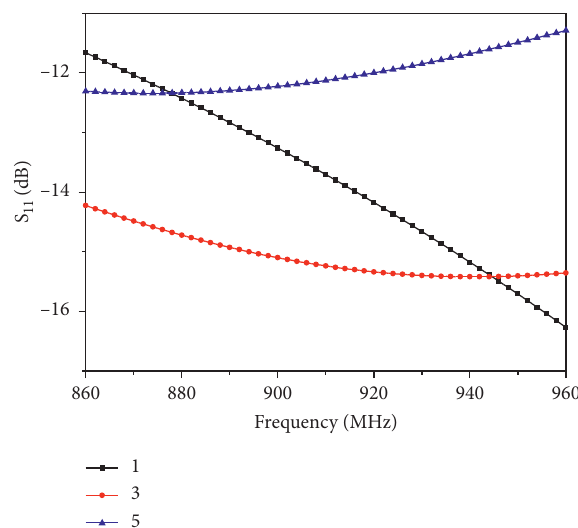
Figure 17: Simulated reflection coefficients of the three-branch antenna with different dielectric